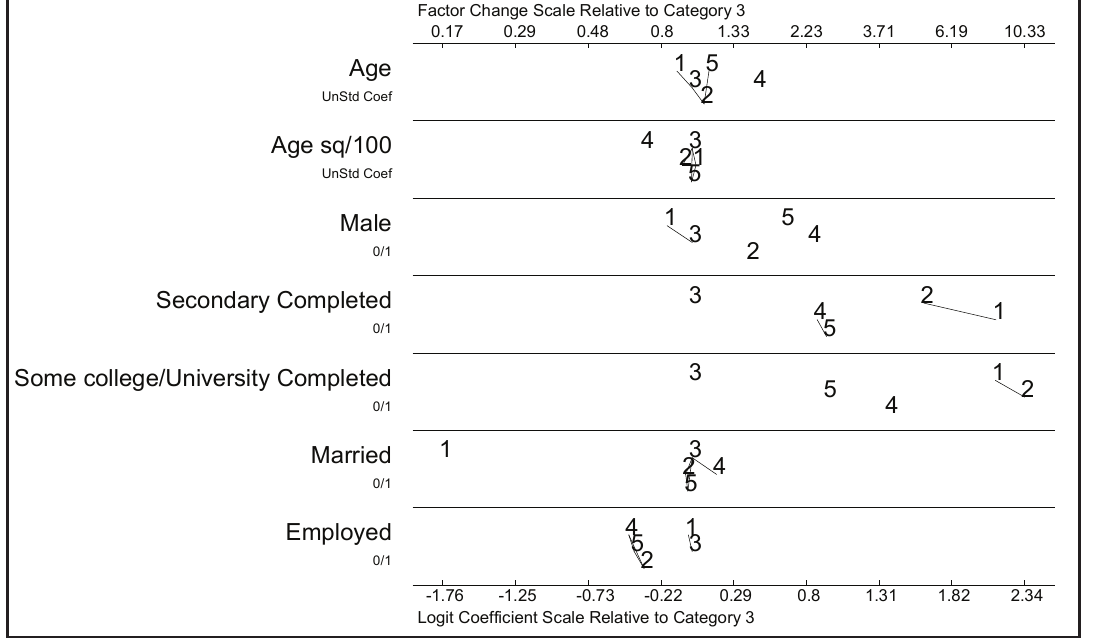
Factor Change Scale Relative to Category 3